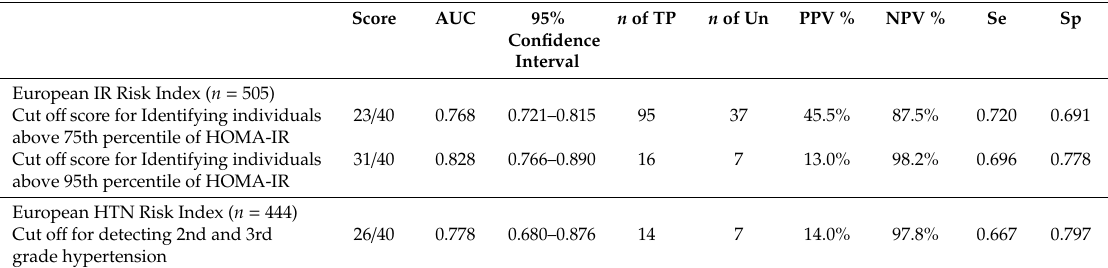
Table 4. ROC characteristics of European IR Risk Index and European HTN Risk Index in the validation